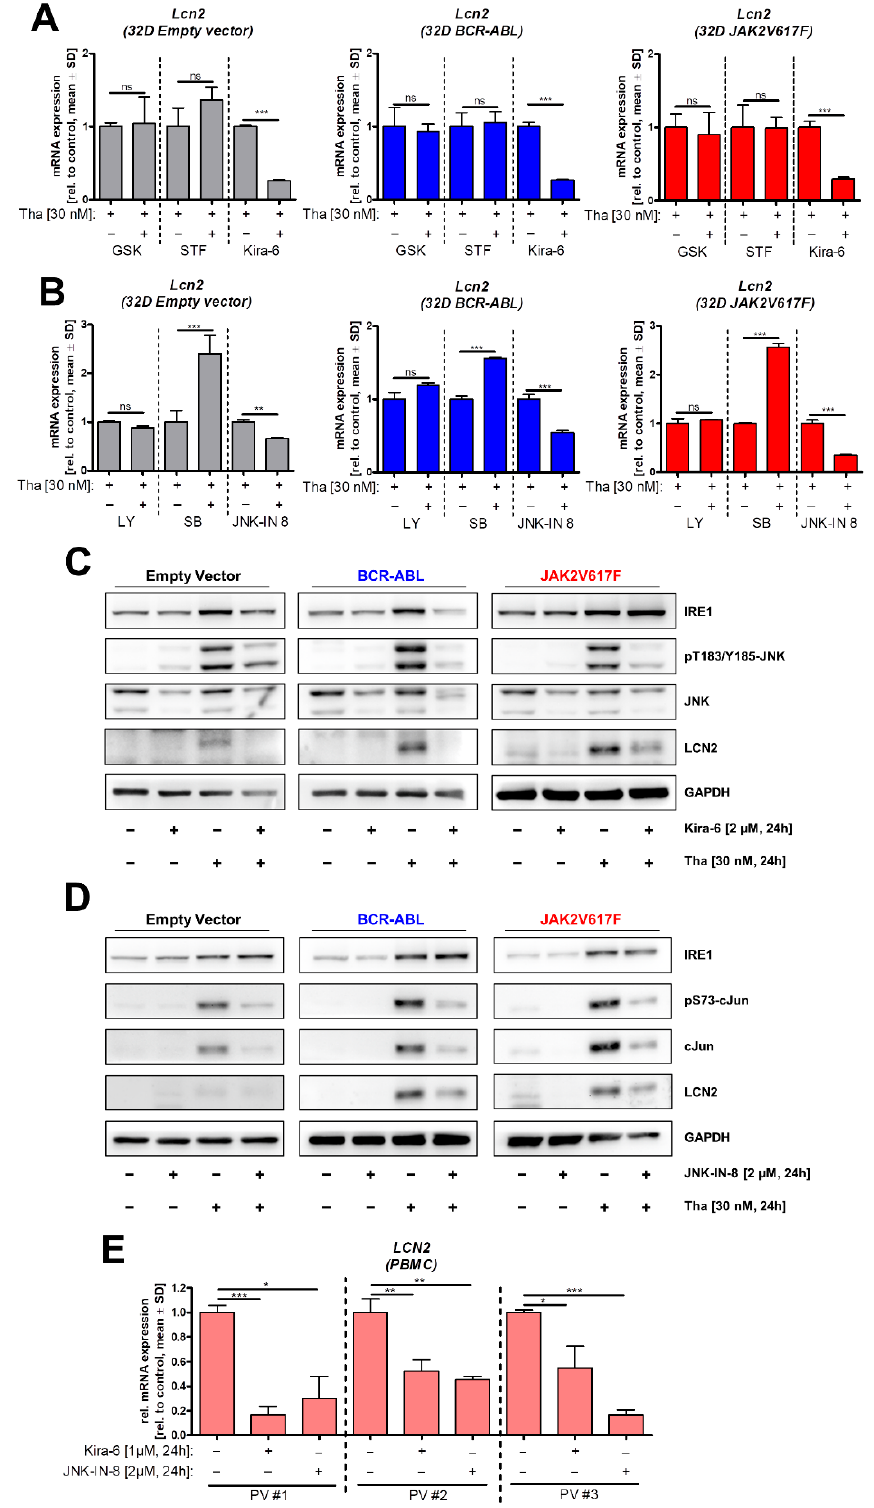
Figure 4. The IRE1–JNK axis regulates Lcn2 induction upon UPR activation. ( A , B ) RT-qPCR analysis of 32D cells treated for 24 h with 30 nM Tha in combination with 100 nM GSK2606414 (GSK), 15 µM STF-083010 (STF), 2 µM Kira-6, 5 µM LY2409881 (LY), 5 µM SB203580 (SB) or 2 µM JNK-IN-8. n = 3, t-test was used to assess differences. ( C , D ) Western blot analysis of 32D cell lysates after treatment with 30 nM Tha in combination with 2 µM Kira-6 or 2 µM JNK-IN-8 for 24 h. n = 3 ( E ) RT-qPCR analysis of RNA isolated from PBMCs of patients diagnosed with polycythemia vera (PV). Cells were treated for 24 h with 1 µM Kira-6 or 2 µM JNK-IN-8 and mRNA was isolated. n = 3, Kruskal-